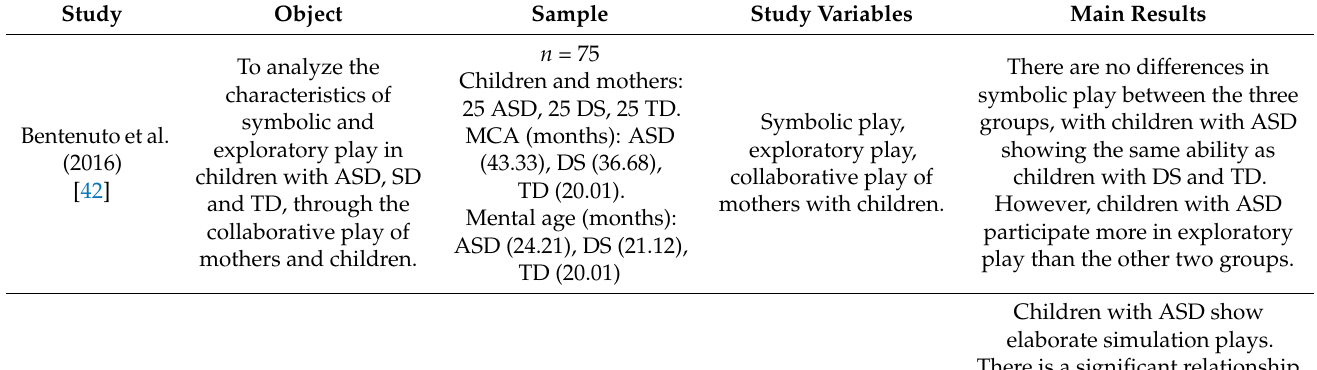
Study Variables Main Results